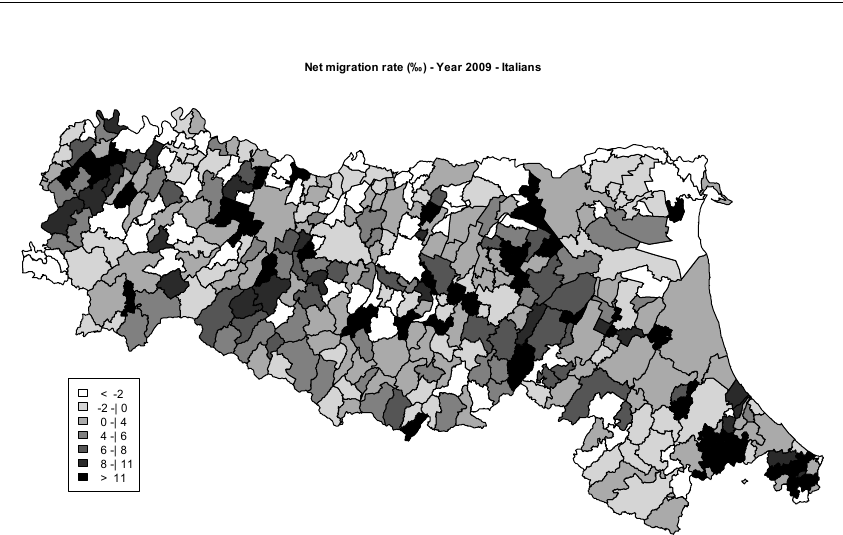
Figure 2 – Spatial distribution of the net migration rate (Italians) in 2009.